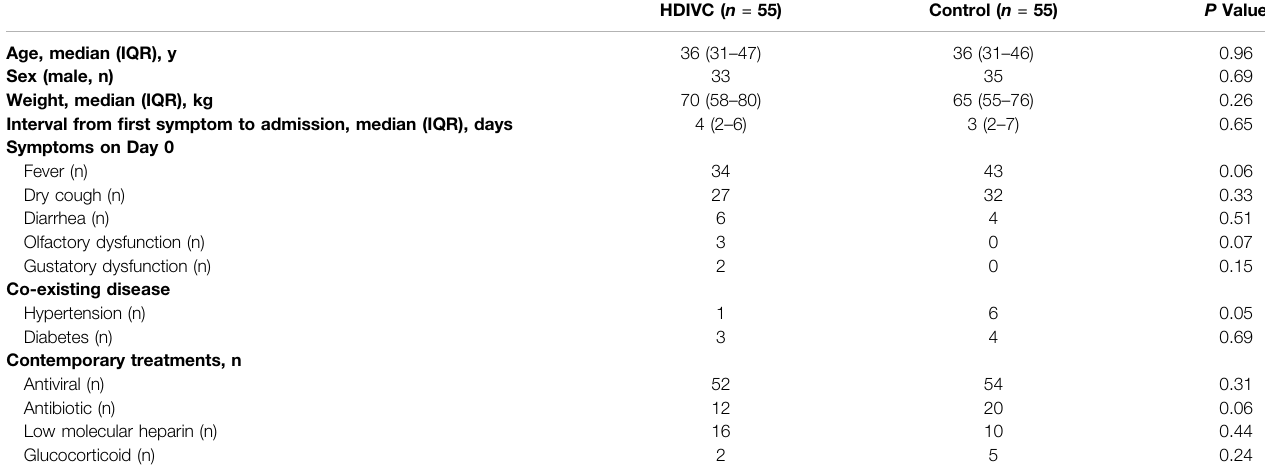
TABLE 1 | Characteristics of COVID-19 patients.